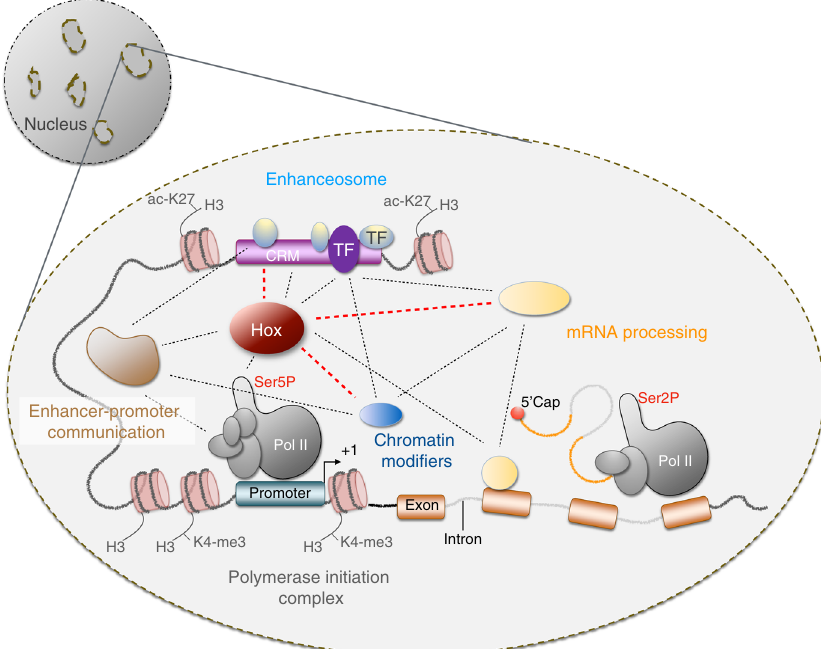
Fig. 7 Model of tissue-speci fi c Ubx transcriptional interactive networks. Ubx speci fi city and functional diversity could be the result of tissue-speci fi c transcriptional networks assembled at the cell-speci fi c level but also at several layers of gene expression. From cis- regulatory module (CRMs) to mRNA processing, it may act as a transcriptional platform integrating multi-layered and inter-connected interactions (dot-lines) with multi-lineage (shadow-grey) or cell-restricted (purple) TFs, regulators of chromatin-contact (shadow brown), basal RNA-polymerase II machinery (grey, pol II), chromatin modi fi ers (blue) and mRNA-processing regulators (orange). Interactions are mainly formed with ubiquitously expressed proteins in a tissue-speci fi c manner (red line) and a few lineage-restricted TFs (purple TF proteins) that might promote speci fi c conformational changes. In the context of transcriptional micro- environments, this might be the fi rst layer of cell-speci fi city driving the assembly of higher-order interactive networks at multiple transcriptional levels in a precise spatial and temporal context. Image adapted from Carnesecchi et al. 12 with